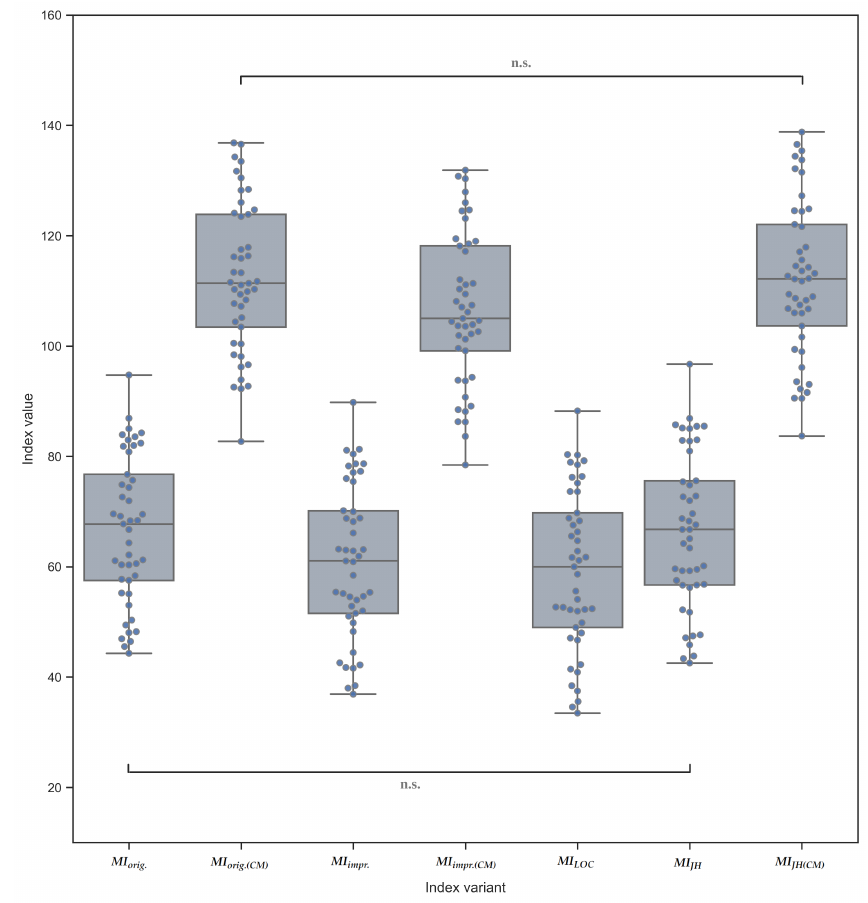
Figure 4. Boxplots of the Index variants values with statistical significance annotation (n.s. = not